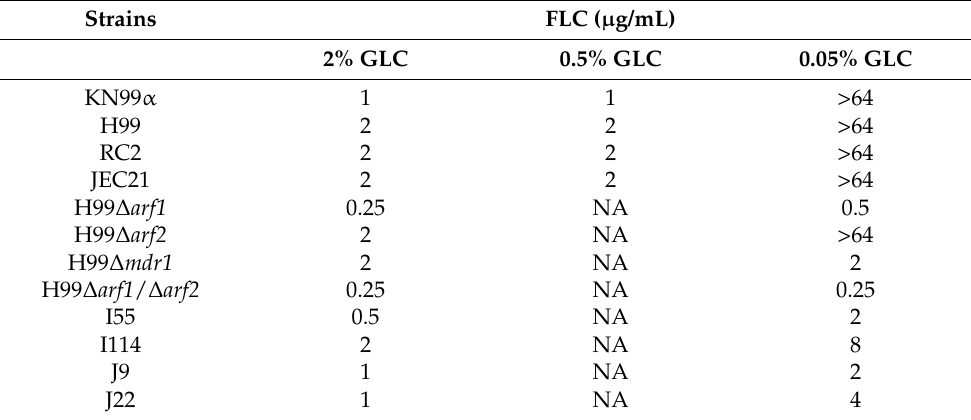
Table 1. Minimum inhibitory concentrations of different C. neoformans